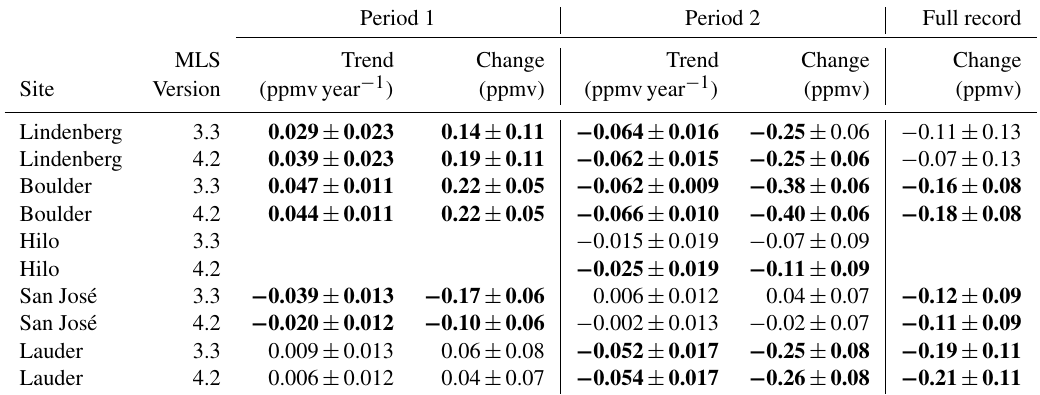
Table 6. Stratospheric average trends and changes in FP–MLS differences. Weighted averages of trends and changes in FP–MLS differences at all eight pressure levels (100–26hPa) over each site. Stratospheric averages are presented with their 95% confidence limits. All values were computed using the regression slopes and their uncertainties in Tables 3 and 5. Values in boldface type are significantly different from zero with 95%